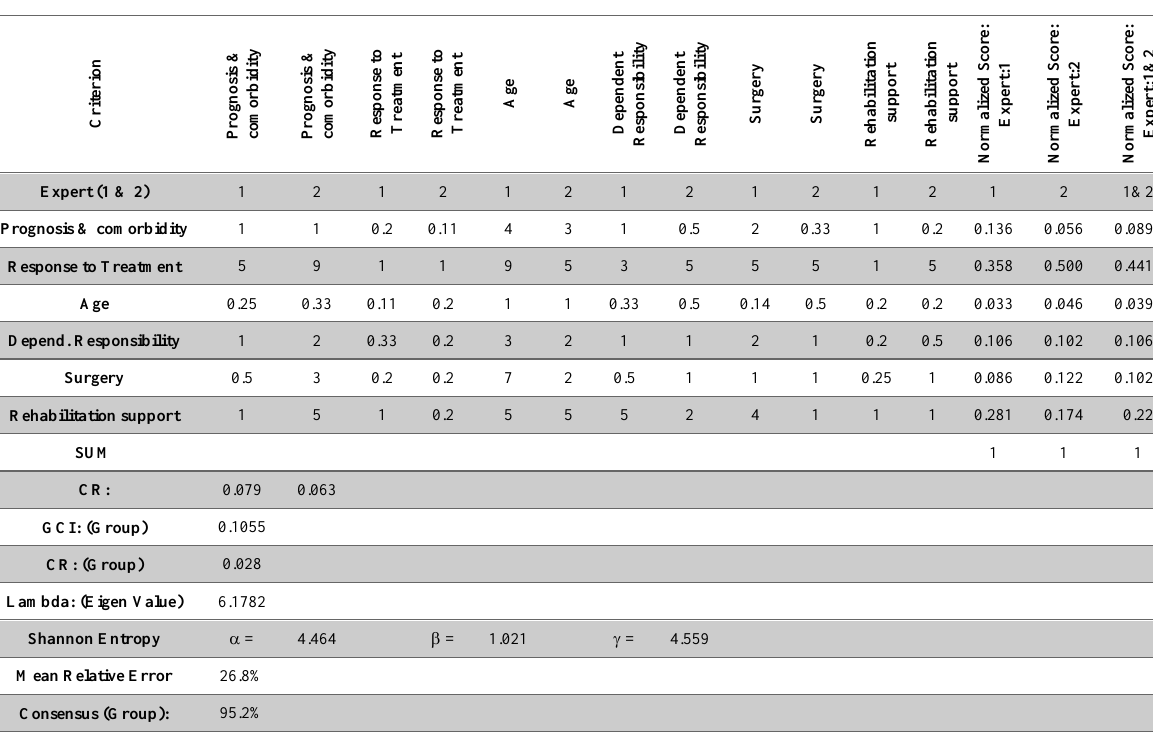
Table 5. Data Collection Reciprocal